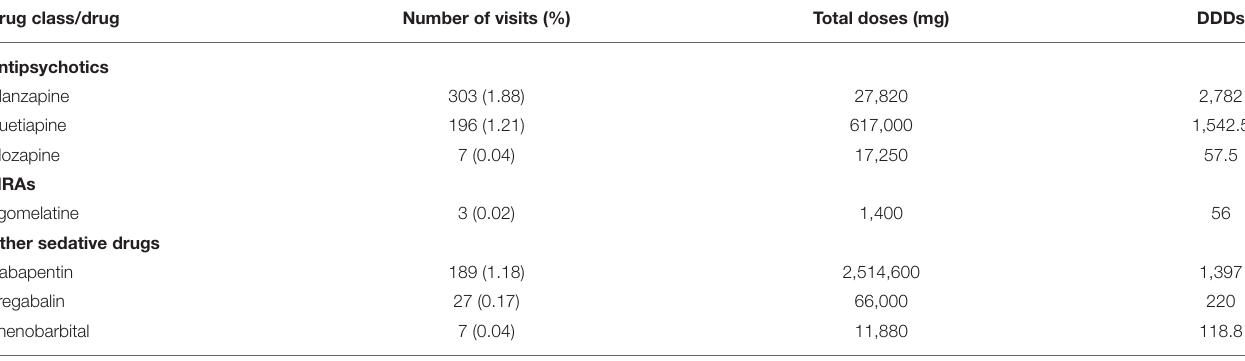
TABLE 5 | Situation of prescribed antipsychotics, MRAs and other sedative drugs in outpatients with insomnia. Drug class/drug Number of visits (%)